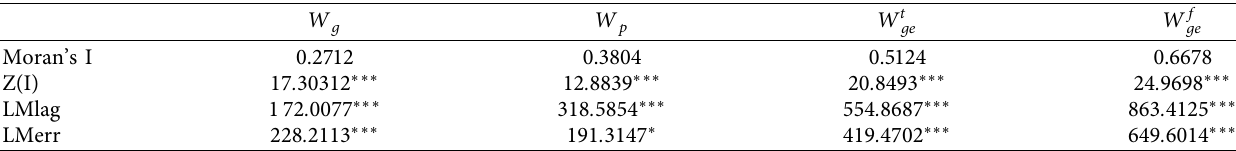
Table 5: Comparison of test results of the spatial weight matrix with other weight matrices.